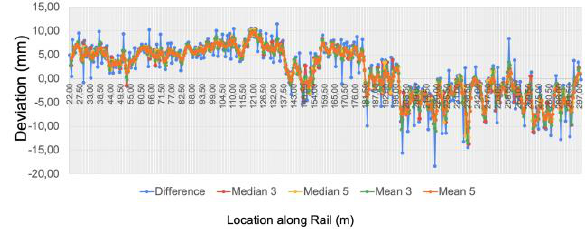
Fig. 11: Difference between the two measurements with different sliding low-pass